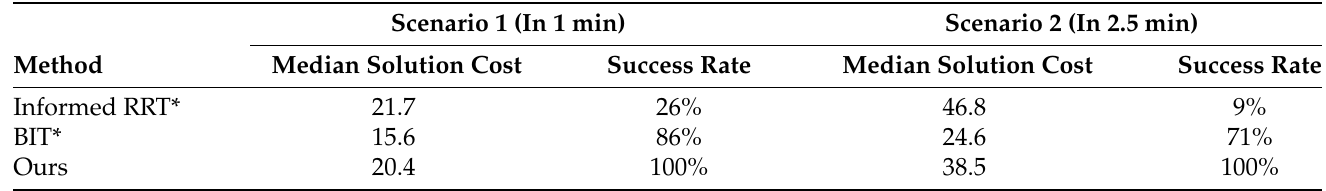
Table 4. Comparison of the success rate and solution cost of planners in specified planning